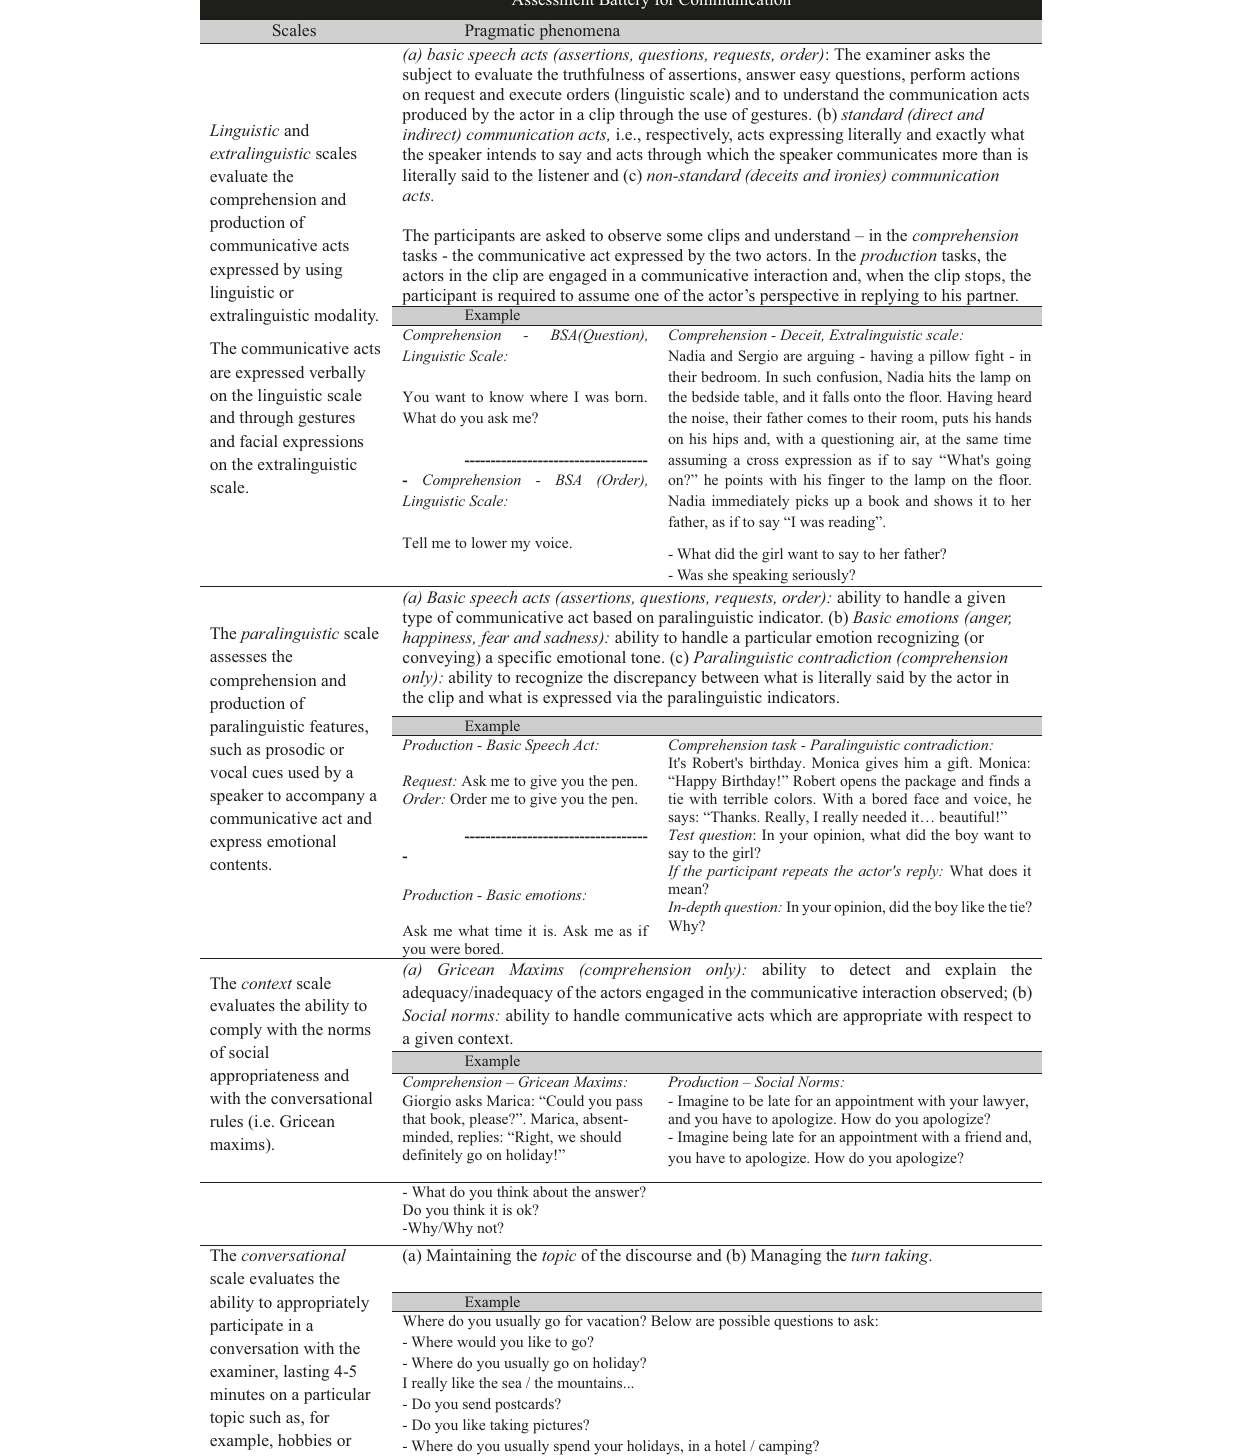
Table 2. Description of the structure of the Assessment Battery for